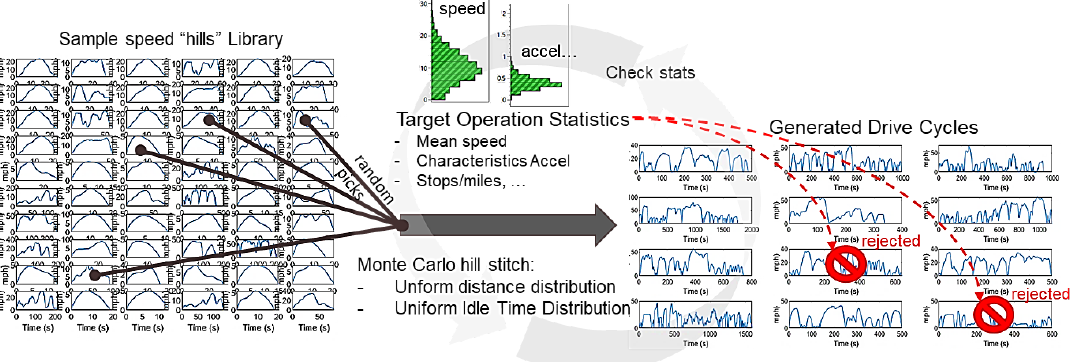
Figure 2. Monte Carlo approach to the generation of 2200 drive cycles for a delivery van